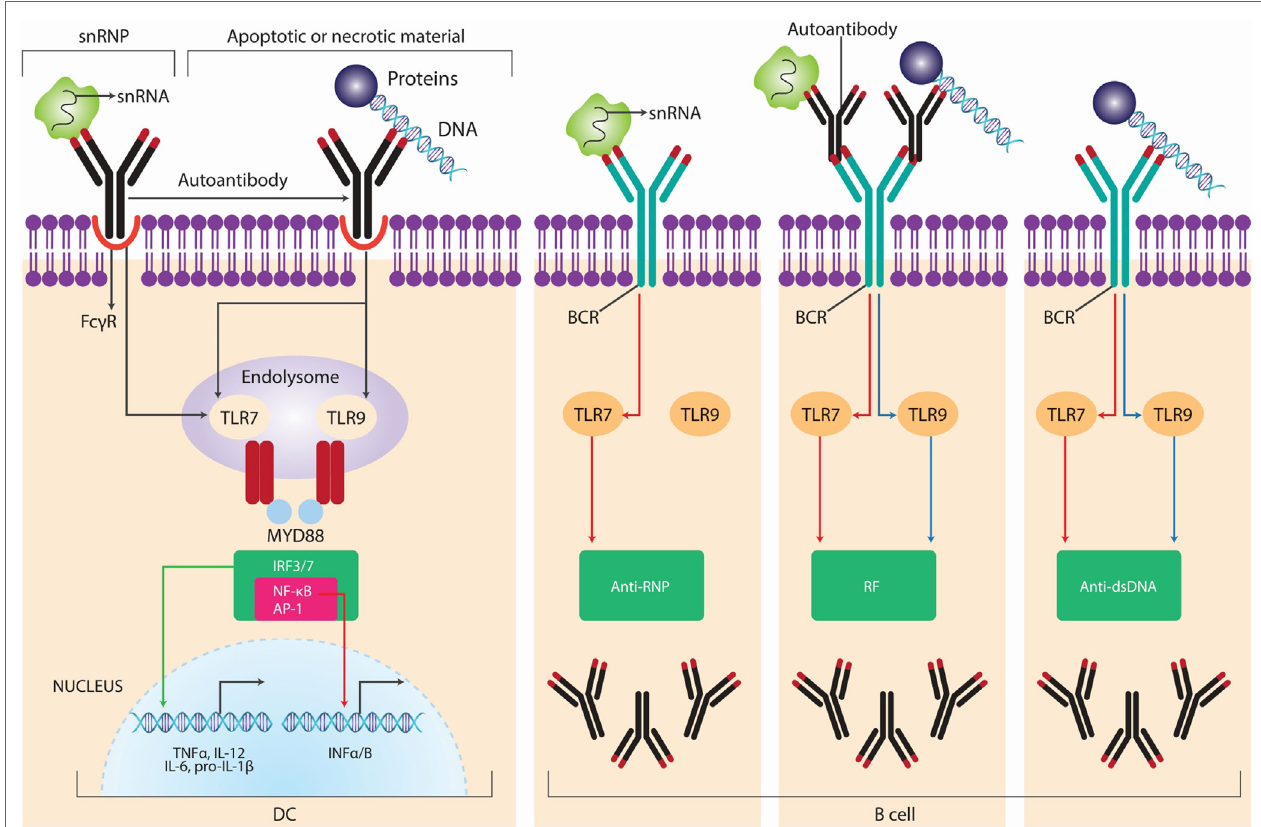
FiGURe 5 | Self nucleic acids recognition by TLRs in autoimmunity . Autoantibodies and autoreactive B-cell receptor BCRs, such as rheumatoid factor (RF) and anti-small nuclear ribonucleoprotein (snRNP) or anti-DNA antibodies mediate the access of self-nucleic acids to endolysosomal toll-like receptors (TLRs), leading to the production of type I interferon (IFN) from dendritic cells (DCs) and autoantibodies of corresponding specificities from B cells. The major snRNP antigen for anti-snRNP autoantibodies contains small nuclear RNA (snRNA), whereas the antigenic targets of anti-DNA autoantibodies are apoptotic or necrotic material containing DNA; accordingly, anti-RNP B cells are activated by TLR7 ligands, whereas anti-DNA or RF-producing B cells are activated by either TLR9 or TLR7 ligands. Adapted from Ref.